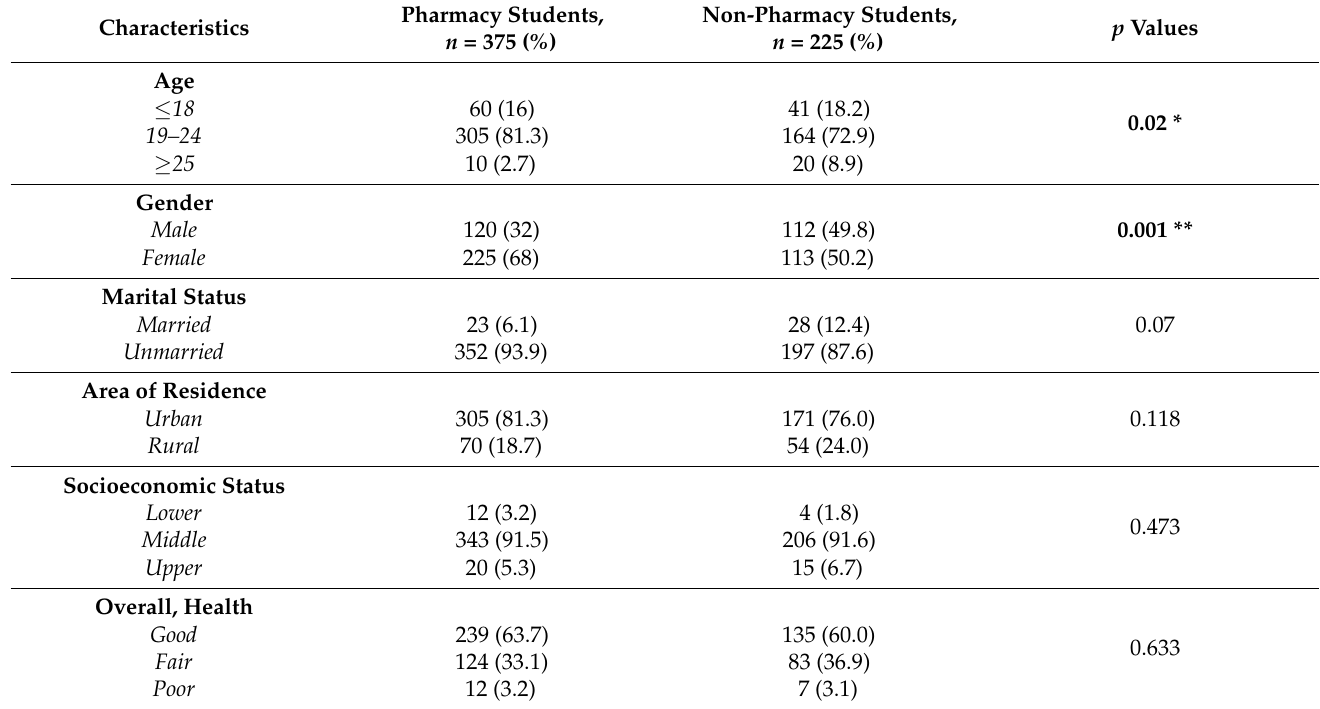
Table 1. Demographics of the students, pharmacy and